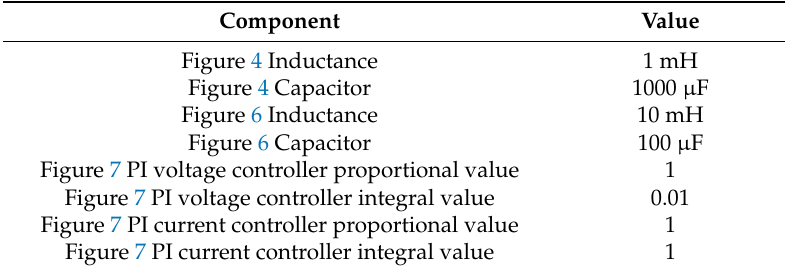
Table 1. Electronic passive components and Proportional Integrator (PI) adjustment.